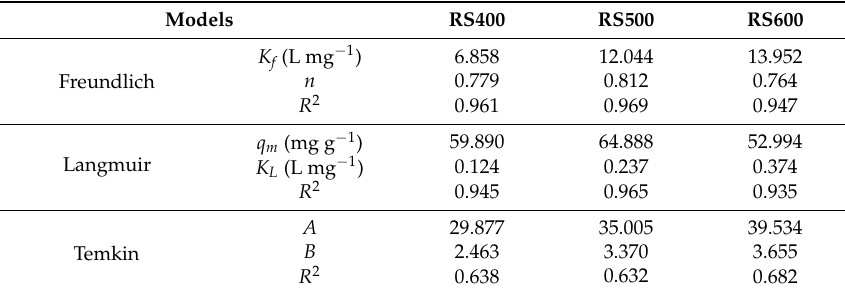
Table 3. Langmuir and Freundlich isotherm parameters.